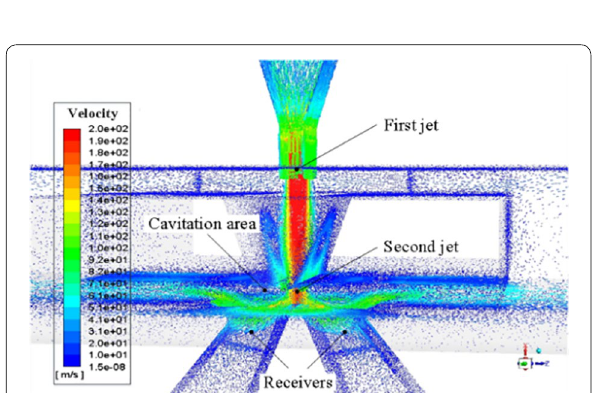
Figure 13 Velocity vectors of 3D flow